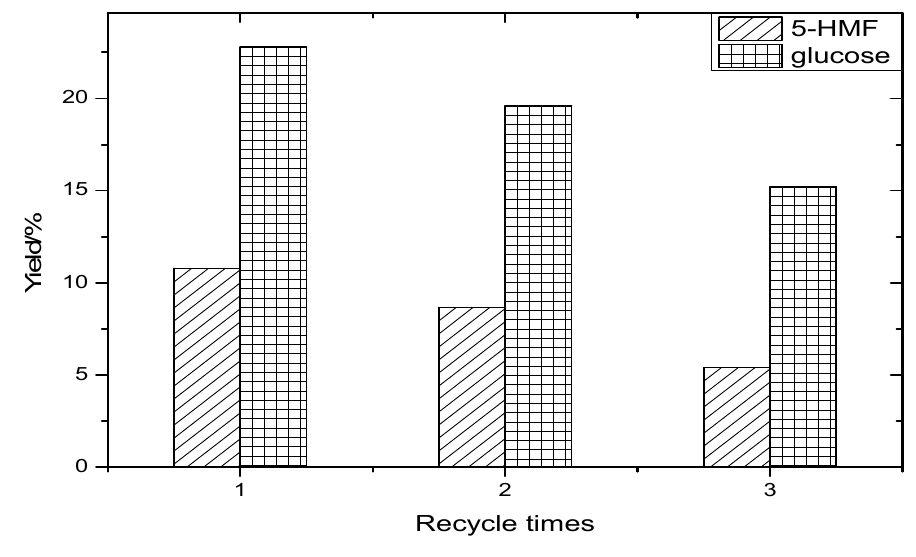
Figure 4. Recycling durations of DES.